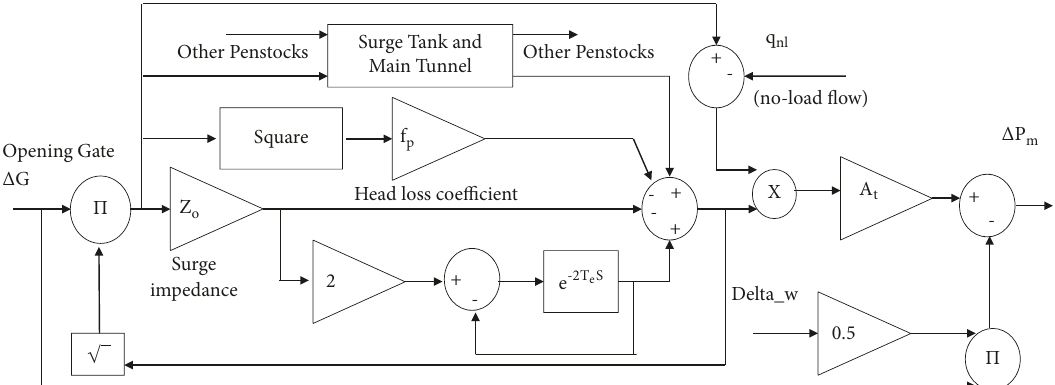
Figure 3: Hydraulic subsystem of the power plant.